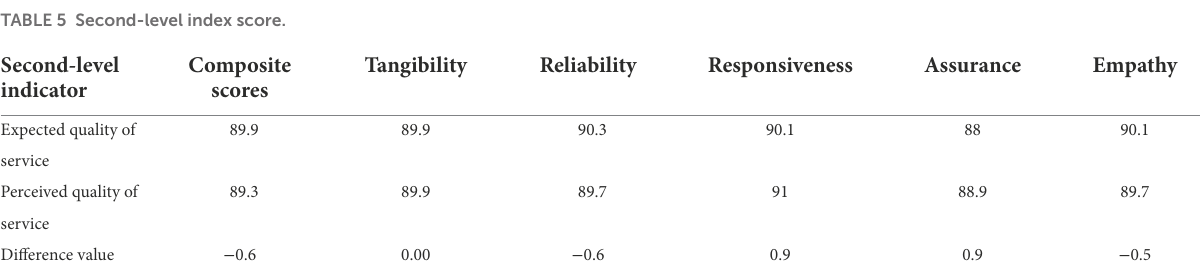
TABLE 5 Second-level index